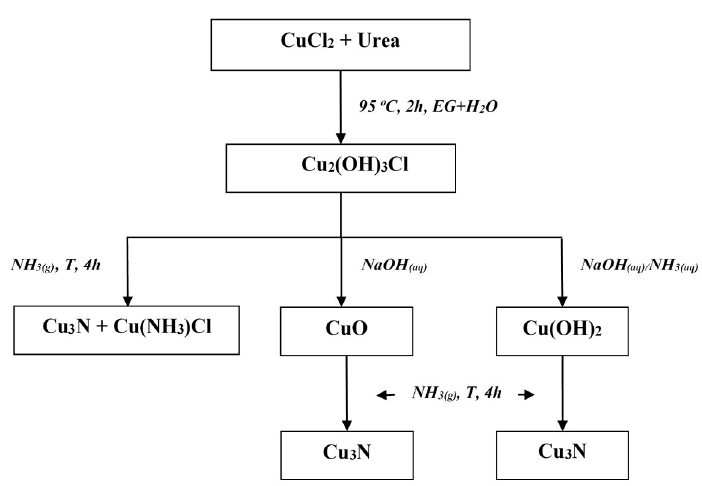
Figure 1. Schematic representation of the preparation processes for the respective powders. surface. The treatment of initial SiO 2 with trimethylsilyl chloride was done as described in literature to completely remove the hydrophilicity on the surface [49–51]. The Cu 3 N/SiO 2 composite preparation procedure was similarly congruent to the synthesis of the unsup- ported Cu 3 N nanoparticles by Cu(OH) 2 powder and resulted in a final Cu 3 N loading